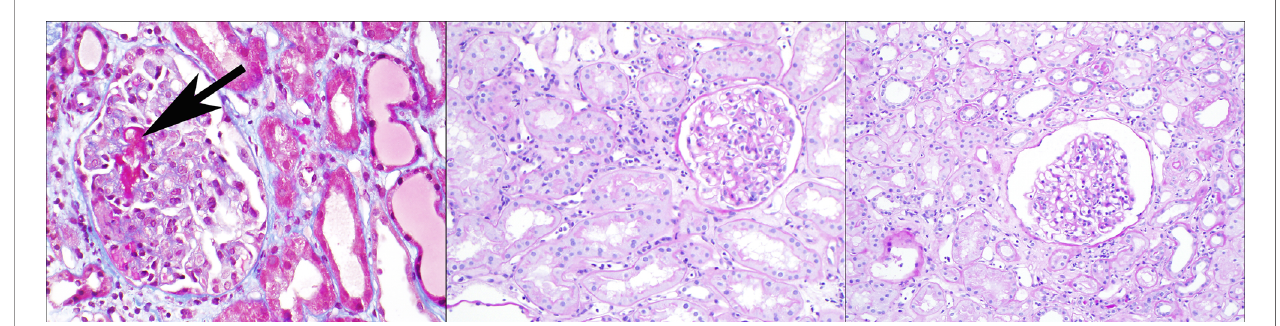
FIGURE 1 | Three clinicopathologic phenotypes of ABMR, one Banff diagnosis: In the left panel (Masson trichrome stain), a patient 2 weeks after positive- crossmatch kidney transplant has acute kidney injury; the biopsy shows glomerular thrombi, acute tubular injury, and minimal capillaritis, and diffuse C4d deposition in peritubular capillaries. In the middle panel (periodic acid Schiff stain), a patient 4 months after positive-crossmatch kidney transplant has stable graft function and undergoes protocol biopsy; the biopsy shows glomerulitis and peritubular capillaritis; C4d staining is negative. In the right panel (periodic acid Schiff stain), a patient 2 years after kidney transplant has stable graft function and undergoes protocol biopsy; the biopsy shows glomerulitis and peritubular capillaritis; C4d staining is negative. All of these biopsies pictured would be assigned the Banff diagnosis of “ active ABMR ” , although clearly the clinical settings